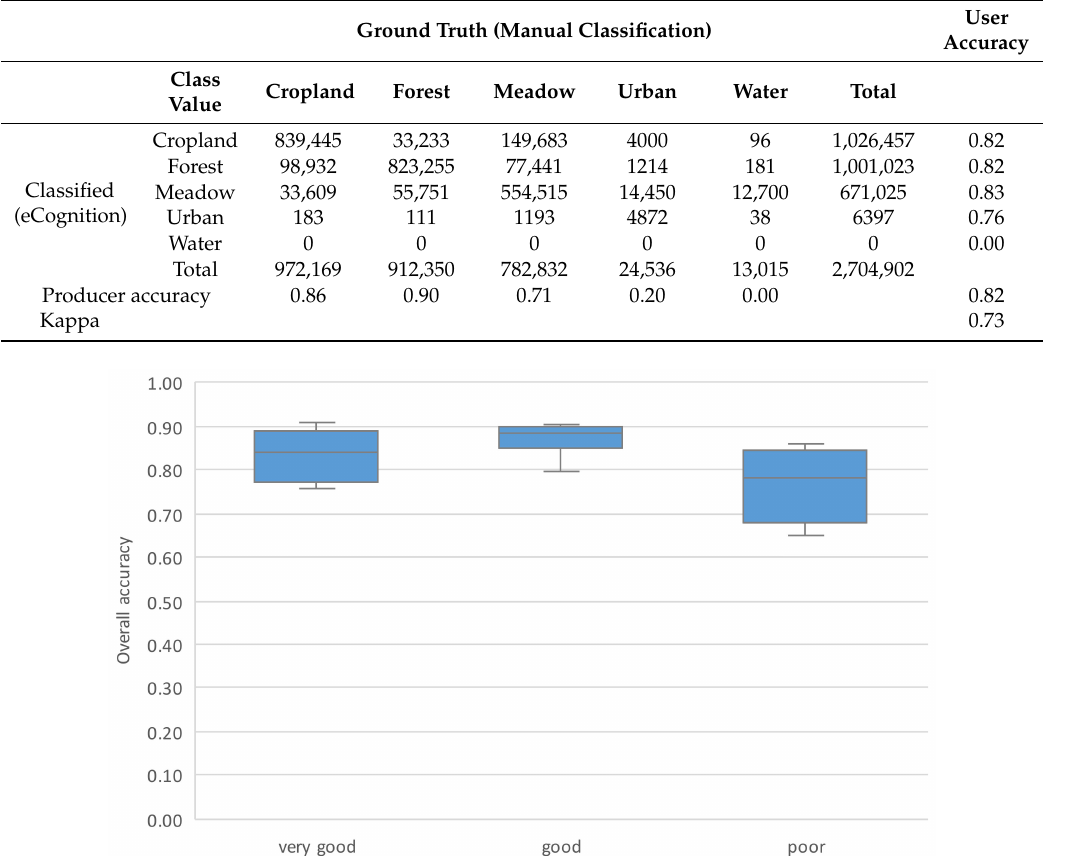
Table 7. Accuracy assessment of manually reclassified area based on 2.7 million grid cells.